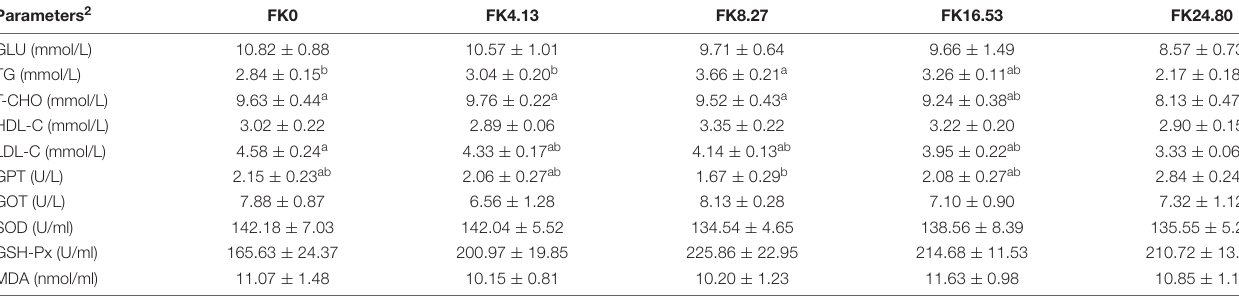
TABLE 7 | Serum biochemical and antioxidative/oxidative parameters of black sea bream fed with different diets 1 . Parameters